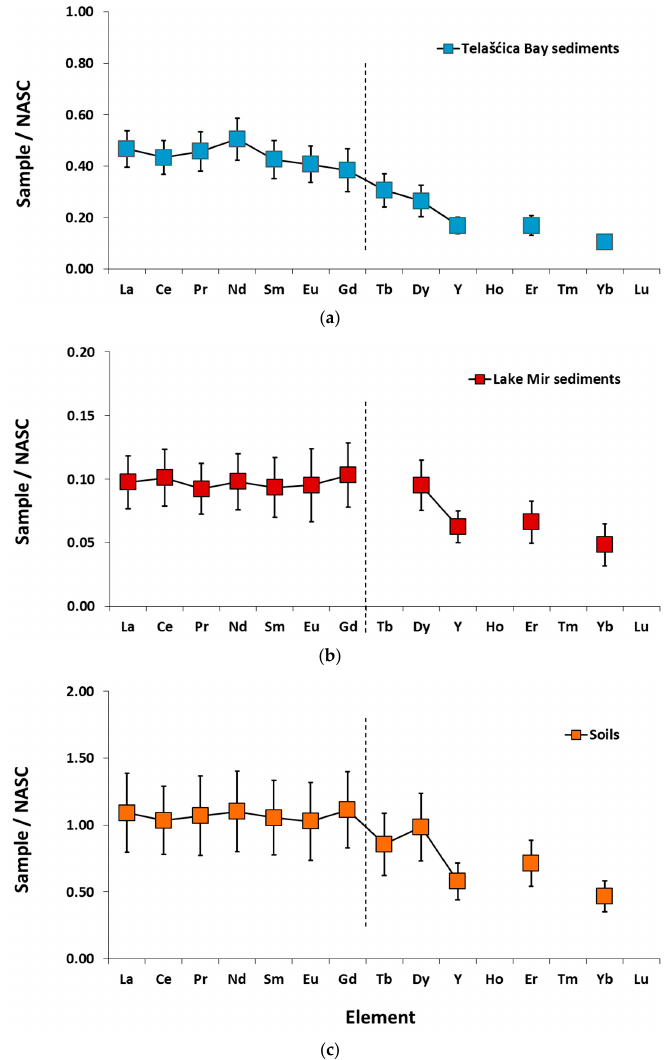
Figure 3. The average REY patterns, normalized to North American Shale Composite, for studied sediments ( a , b ) and soils ( c ), with indicated standard deviation. (dashed line separates light rare earth elements (LREE) (La–Gd) from heavy REE (HREE) (Tb–Lu, including Y)).